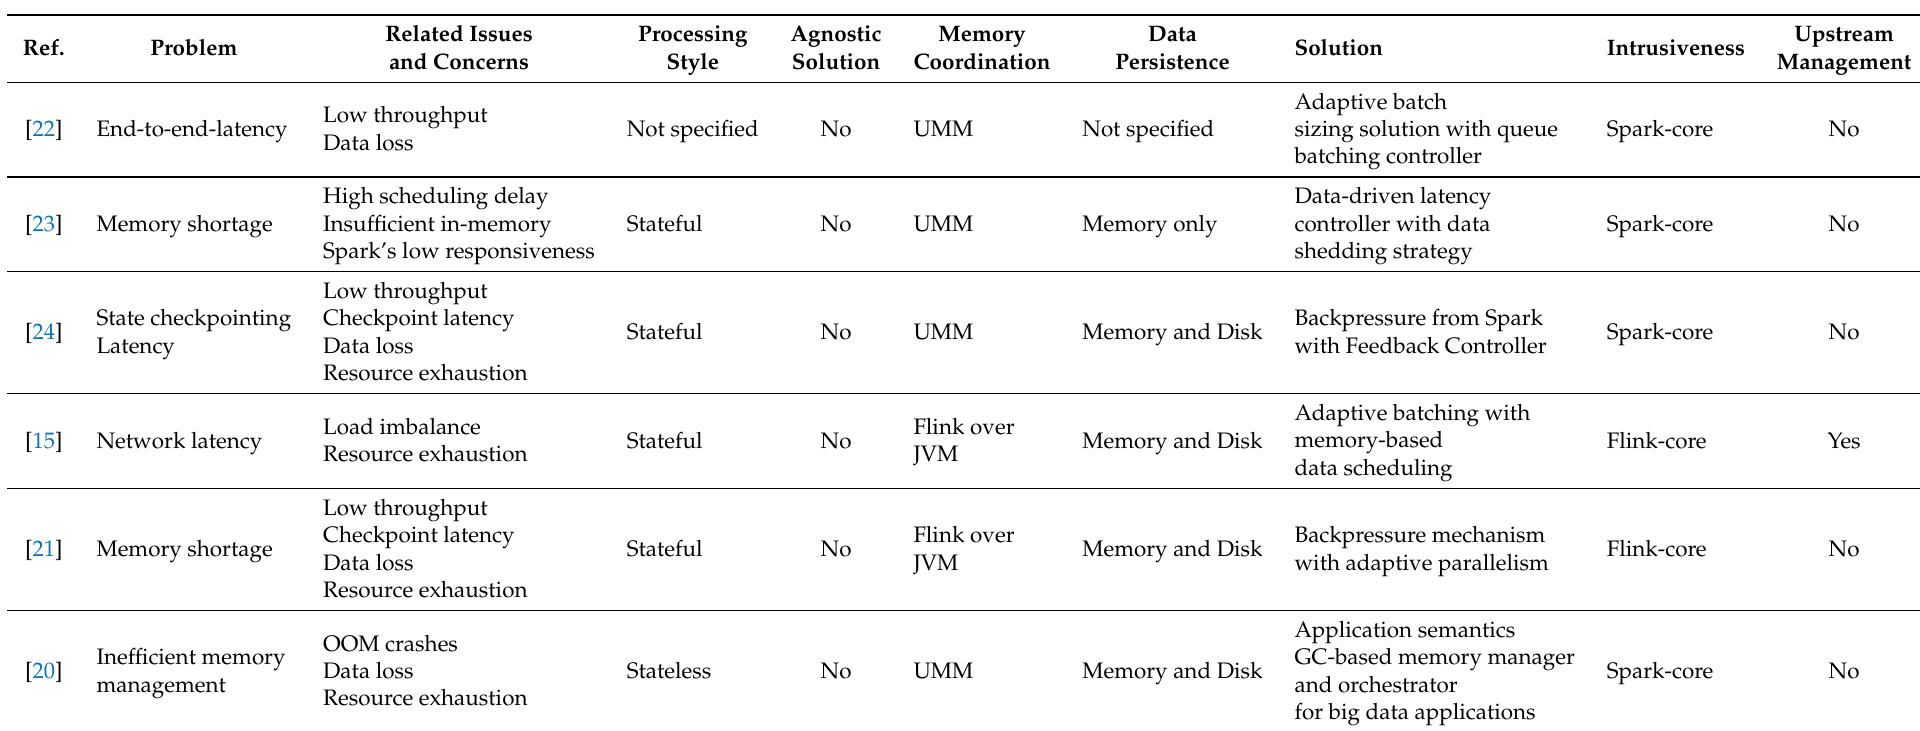
Table 1. Related Work: detailed